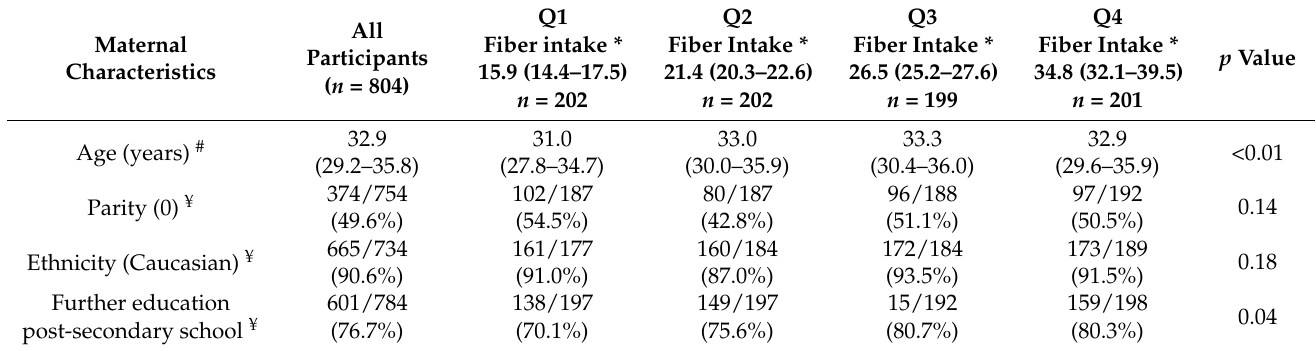
Table 1. Participant demographic characteristics according to dietary fiber-intake quartiles (Q1–Q4).